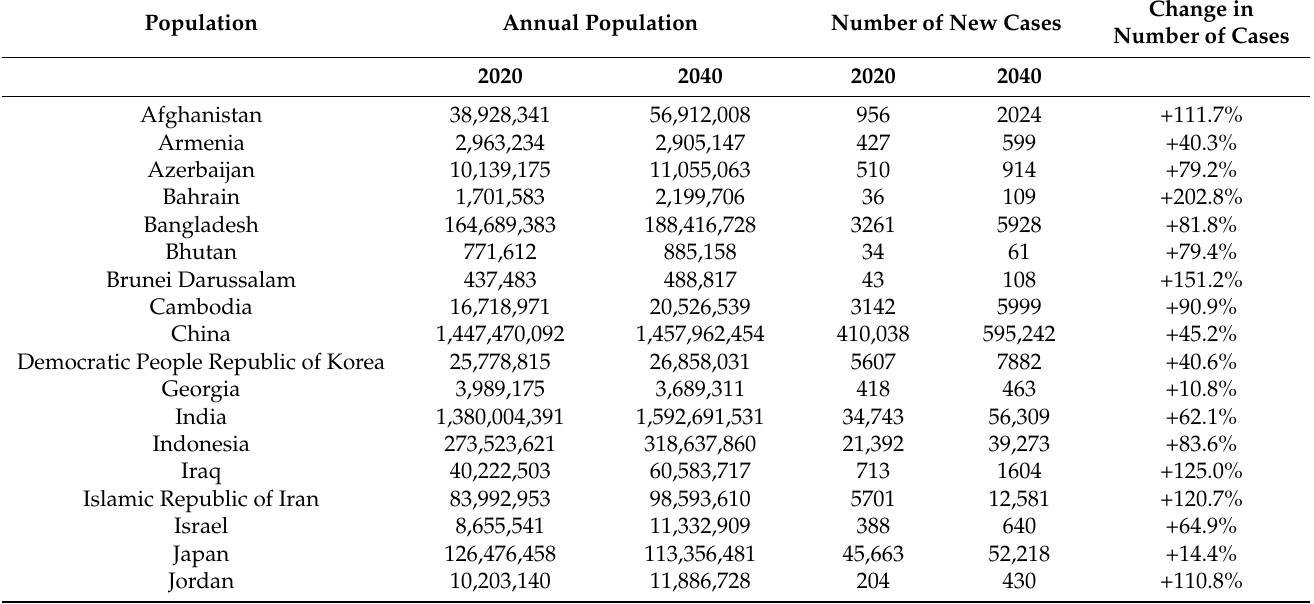
Table 1. Estimated number of new cases of liver cancer in Asia from 2020 to 2040, Incidence, both sexes, age [0–85+], based on